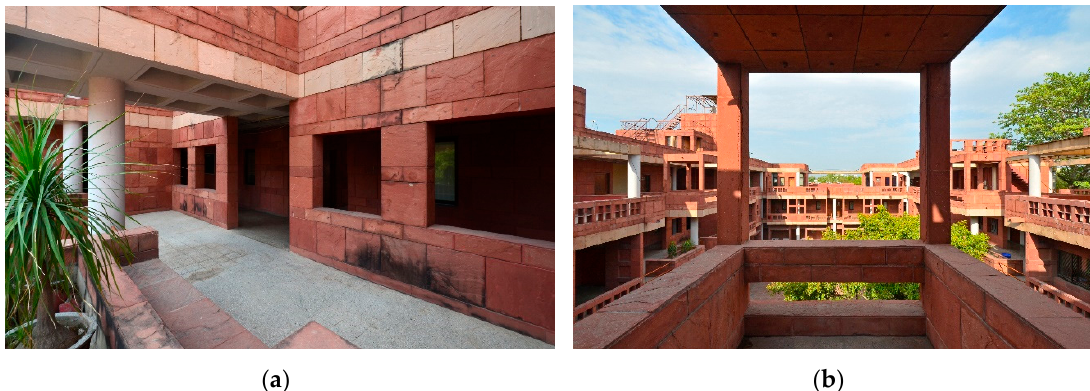
Figure 9. ( a ) Seating enclosure adjoining the corridor on the second floor level of the CIET building; ( b ) view from underneath a chhatri (canopy) on the uppermost level of the CIET building (Photos: Author).